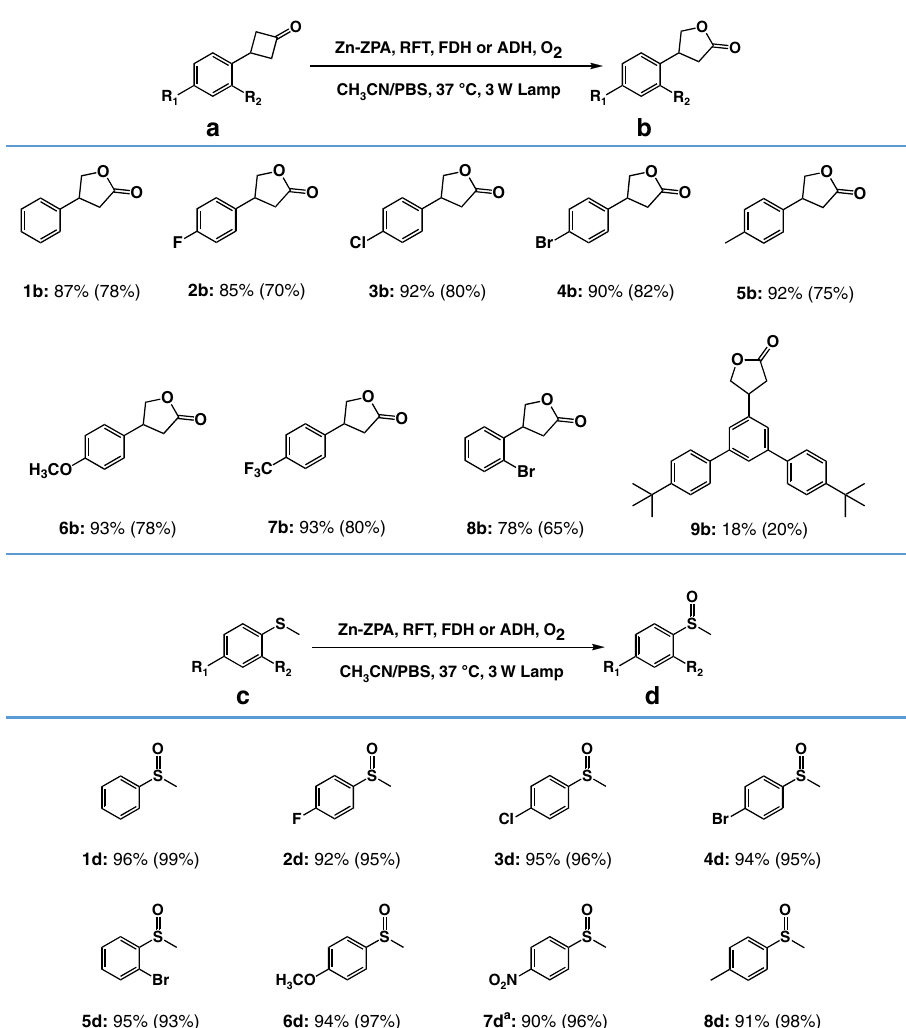
Fig. 7 Scope of the monooxygenation under light irradiation. For substituted phenylcyclobutanone: substrate (8.0 mM), Zn – ZPA (1.6 mM), RFT (1.6 mM), FDH (2 U mL − 1 ) and HCOONa (16.0 mM) in a CH 3 CN/PBS solution (2:1), 3 W fl uorescent lamp, 18 h. The yields obtained with ADH (120 U mL − 1 ) and CH 3 CH 2 OH (3% in volume) instead of FDH and HCOONa are shown in parentheses. For substituted thioanisole: substrate (8.0 mM), Zn – ZPA (0.16 mM), RFT (0.16 mM), FDH (1 U mL − 1 ) and HCOONa (16.0 mM) in a CH 3 CN/PBS solution (2:1), 3 W fl uorescent lamp, 4 h. The yields obtained with ADH (60 U mL − 1 ) and CH 3 CH 2 OH (3% in volume) instead of FDH and HCOONa are shown in parentheses. The yields were determined by 1 H NMR analysis of the products. a 12